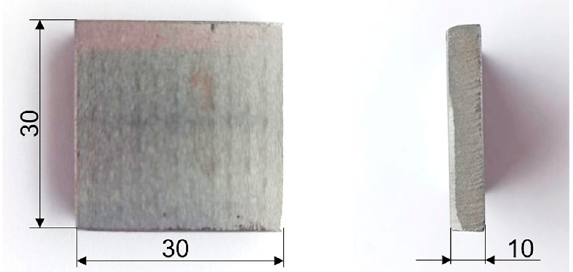
Figure 6. Sample for abrasion resistance test with marked dimensions.